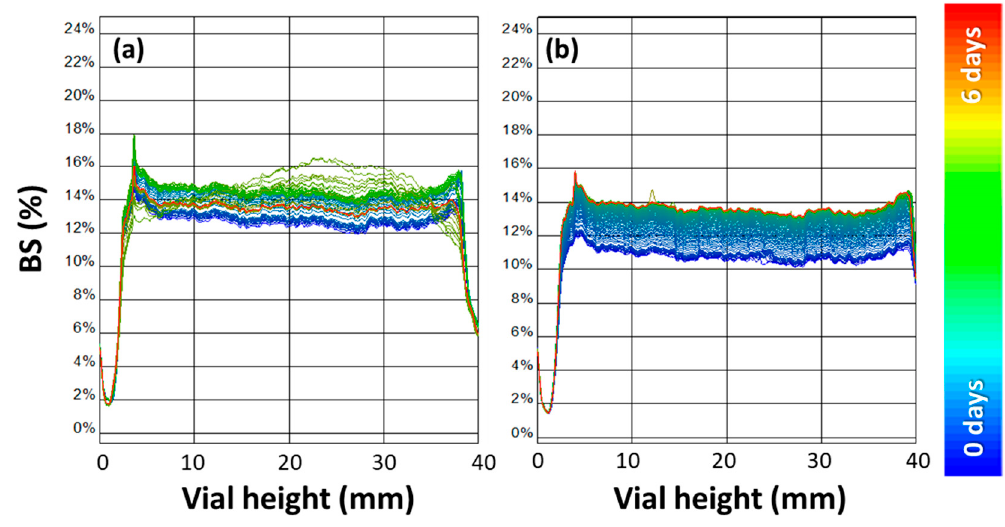
Figure 7. Backscattering profile (%) vs. vials height (mm) acquired over 6 days. Signal of the